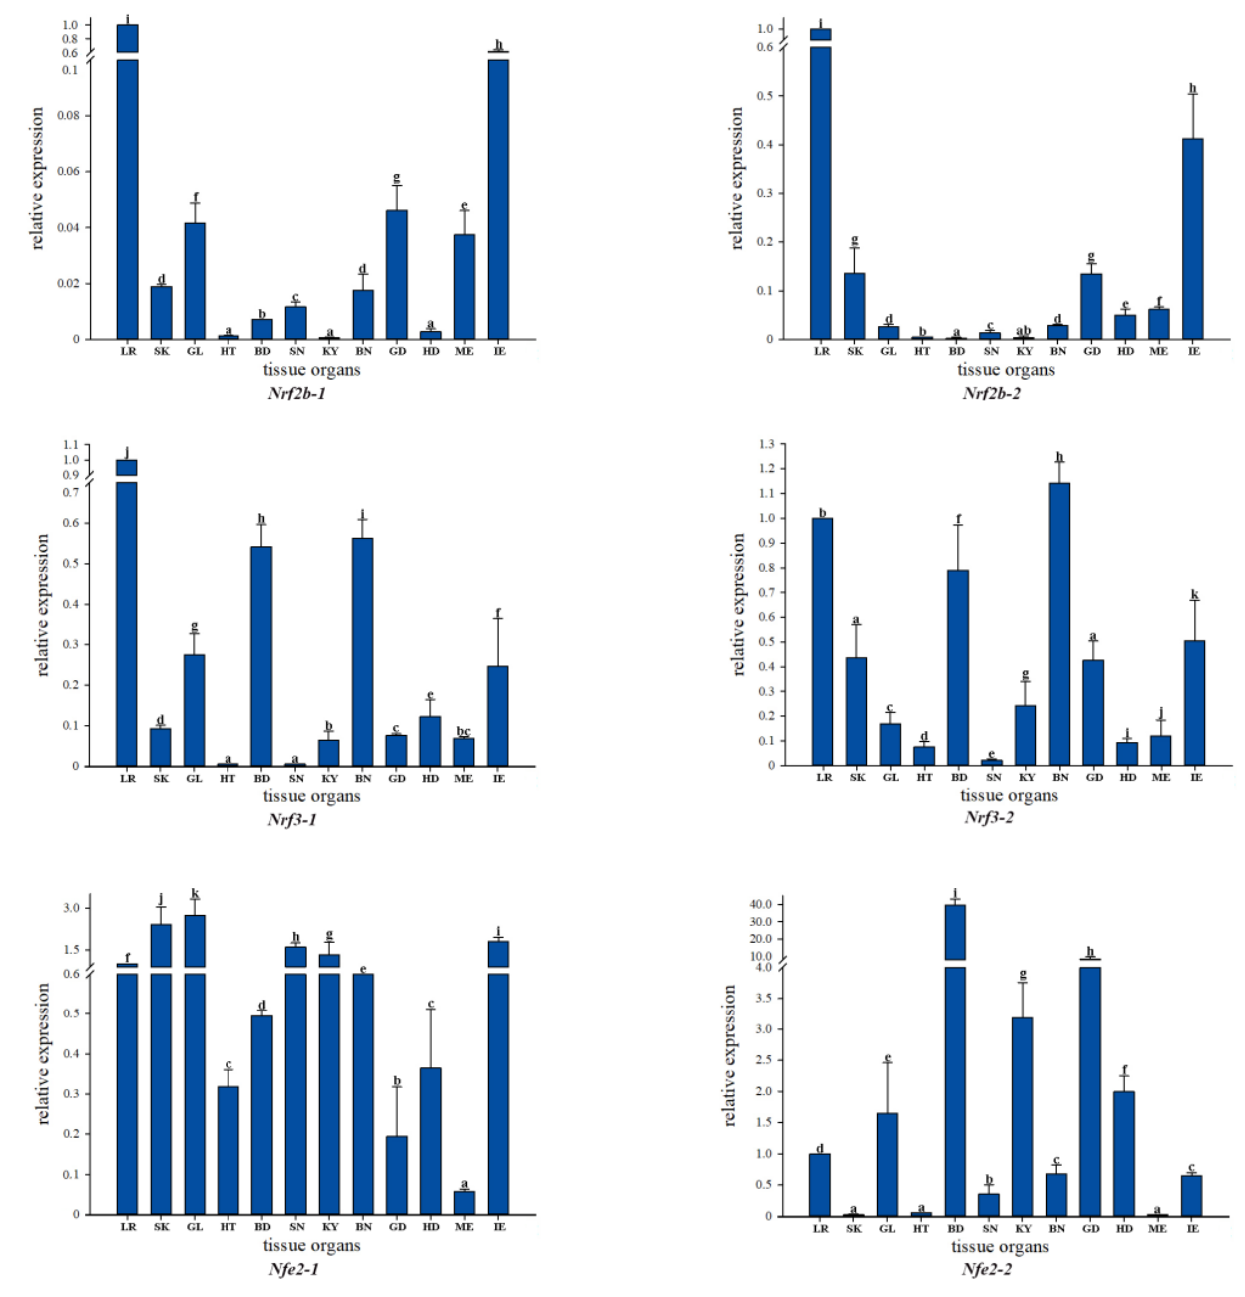
Figure 4. qRT-PCR-based expression analysis of Nrf genes in different tissues of healthy common carp: LR (liver), SK (skin), GL (gill), HT (heart), BD (blood), SN (spleen), KY (kidney), BN (brain), GD (gonad), HD (head kidney), ME (muscle), and IE (intestine). Overall, compared with the control/stress group, B. coagulans at L1, L2, and L3 concen- trations increased Nrf genes expression, which enhanced the body’s detoxification